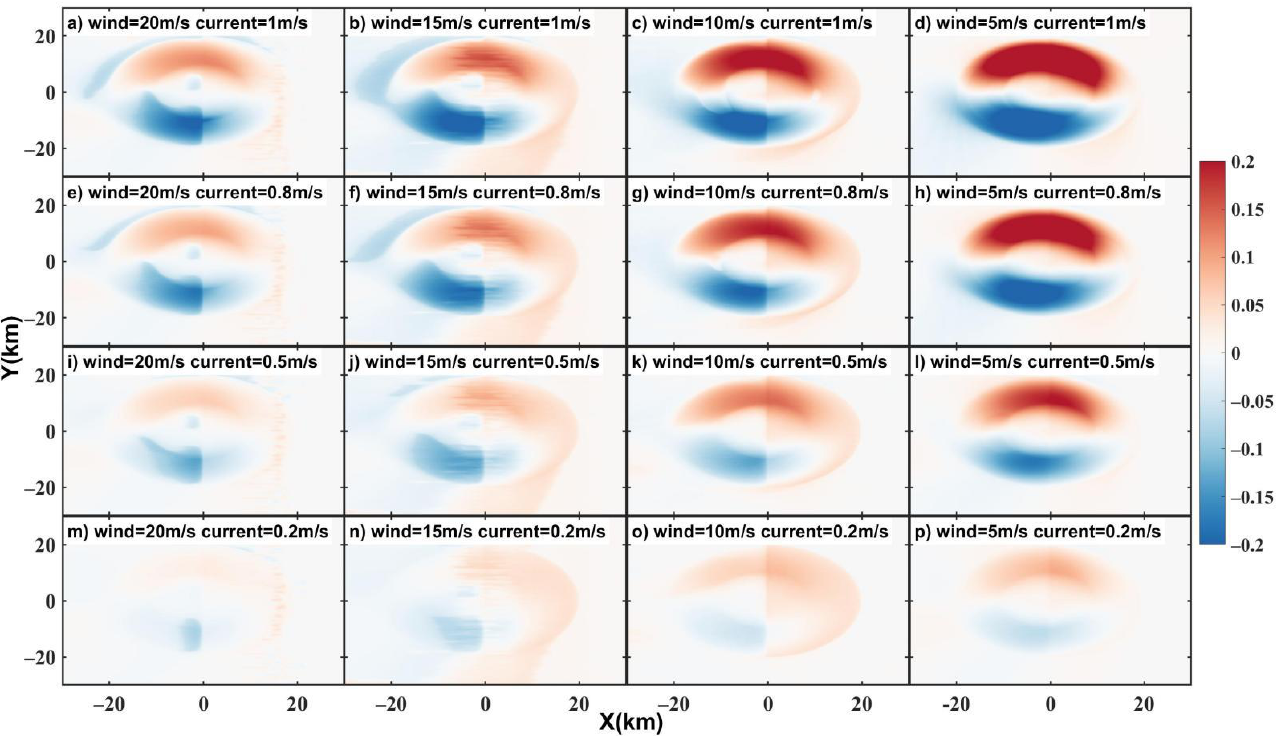
Figure 4. Same as Figure 3, but for peak wave period.